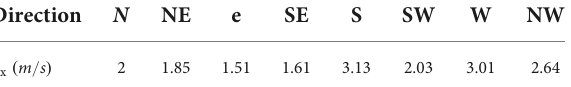
TABLE 10 Average wind speed of each wind direction throughout the year. Direction